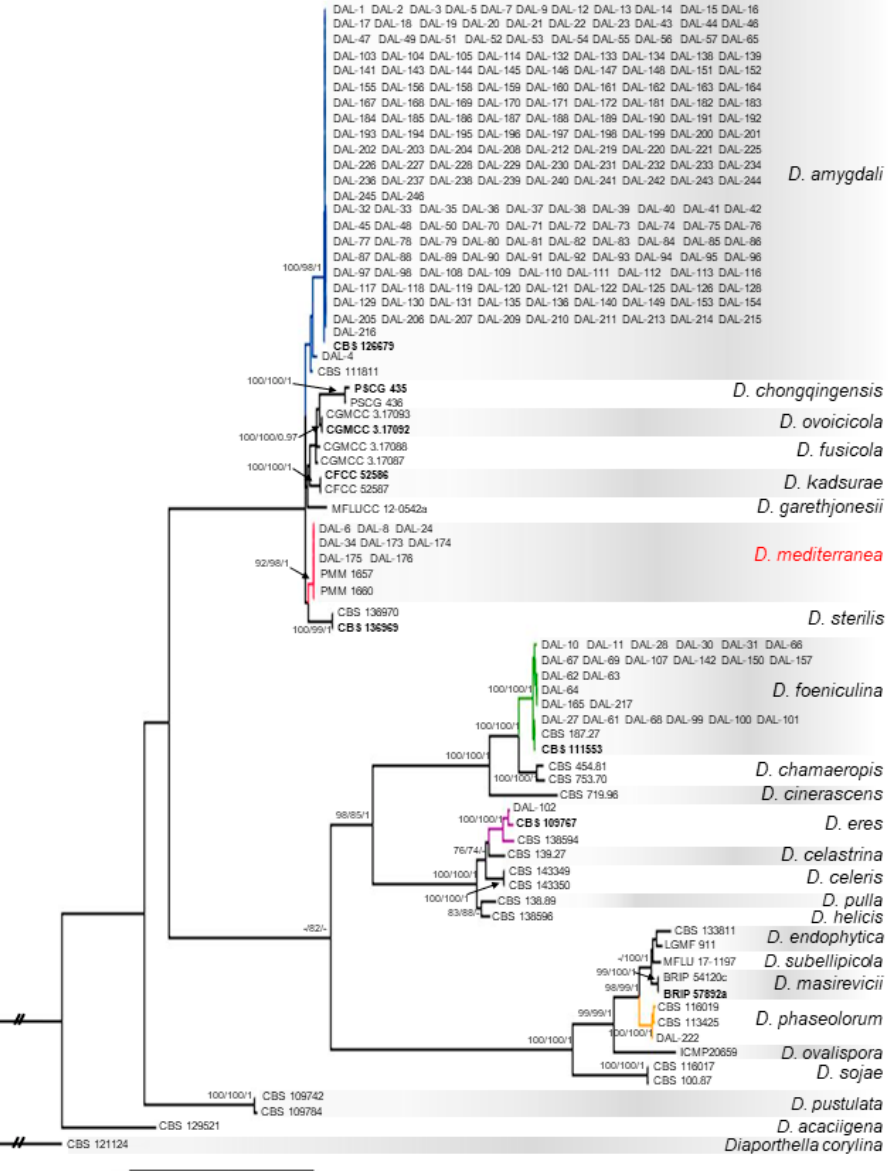
Figure 2. Randomized Axelerated Maximum Likelihood (RAxML) tree based on analysis of a combined dataset of ITS, tub , tef-1 α , his and cal sequences. Bootstrap support values for Maximum Parsimony (MP) and ML higher than 70% and Bayesian posterior probabilities (PP) higher than 0.90 are shown at the branches (MP / ML / PP). Clades highlighted contain the isolates identified in the current study and the novel taxa is shown in red. Ex-type strains are indicated in bold. The tree is rooted using Diaporthella corylina (CBS121124). The scale bar represents the expected number of nucleotide substitutions per